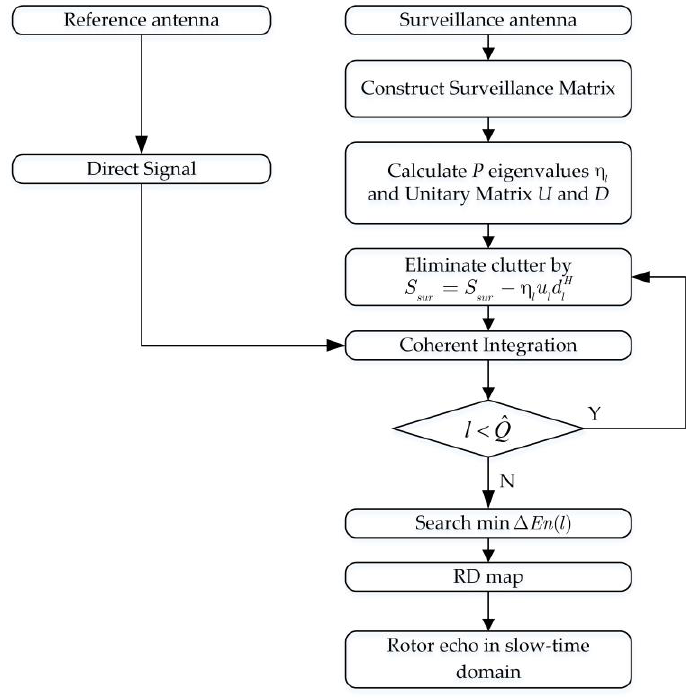
Figure 4. The clutter suppression procedure.